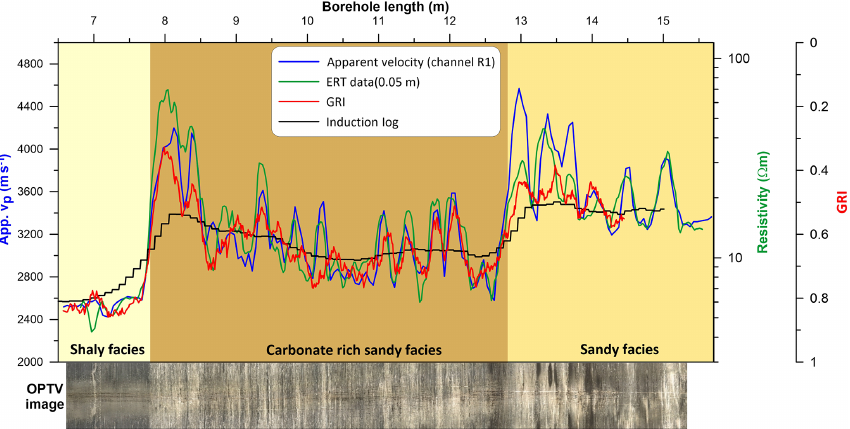
Figure 4. Comparison of geophysical and geotechnical data measured in borehole BWS-I-2, crossing the transition lower shaly, carbonate- rich sandy, and sandy facies (after Furche et al.,